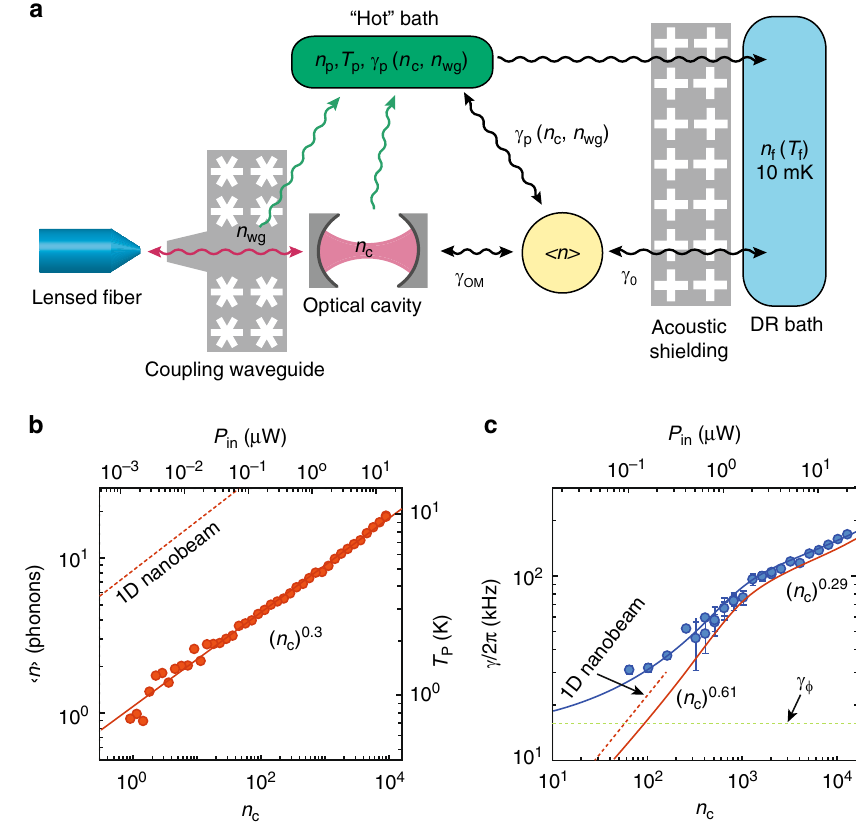
Fig. 4 Optical-absorption-induced hot bath. a Diagram illustrating the proposed model of heating of the mechanics due to optical absorption and the ¼ ð 1 : 1 Þ ´ n 0 : 3 various baths coupled to the localized mechanical mode. b Plot of measured n p versus n c . The solid line is a fi t to the data giving n . Dashed p c line indicates n p versus n c for a 1D nanobeam device measured in ref. 32 for comparison. c Plot of measured linewidth γ (blue dots) versus n c . The blue solid = 2 π ¼ 14 : 54 kHz þ ð 1 : 1 kHz Þ ´ n 0 : 61 line is a power-law fi t to the data, where in the low n c regime γ = 2 π (cid:3) γ ϕ = 2 π þ γ and in the high n c regime c p γ = 2 π ¼ 23 : 91 kHz þ ð 9 : 01 kHz Þ ´ n 0 : 29 . The red solid curve is the resulting fi t for γ p by itself. For comparison, the dashed red curve is a plot of γ p versus n c c for a 1D nanobeam device from ref. 32 . Error bars correspond to 90% con fi dence interval in fi t to Lorentzian spectral linewidth (error bars smaller than the symbol are not shown). In b , c the quasi-2D OMC cavity measurements are for the same 8-shield device as in Fig.